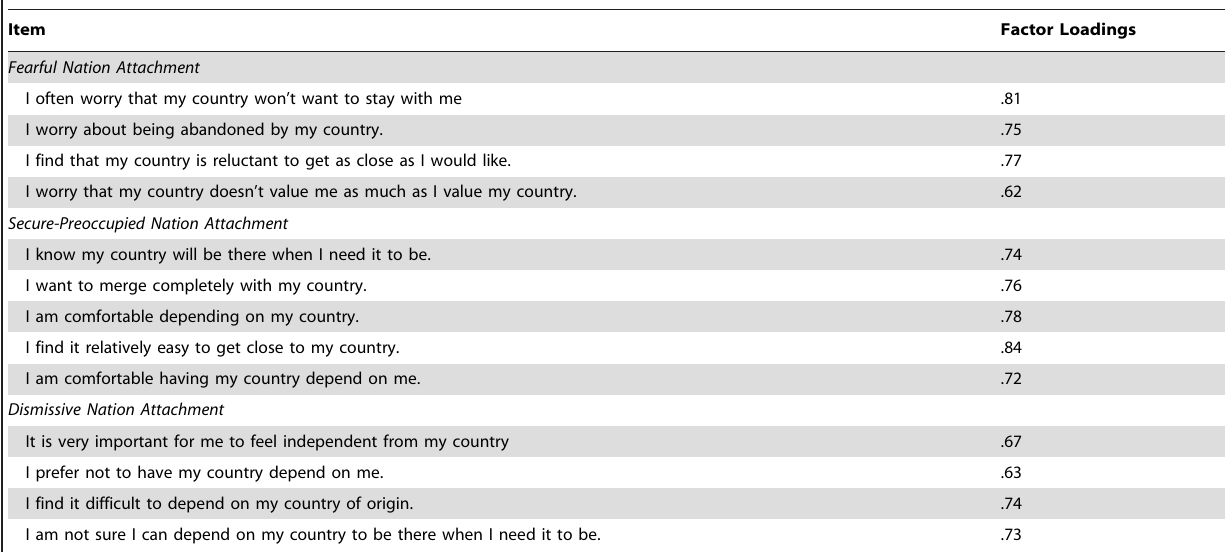
Table 5. Retained Items for the Nation Attachment Scale (Study 2).